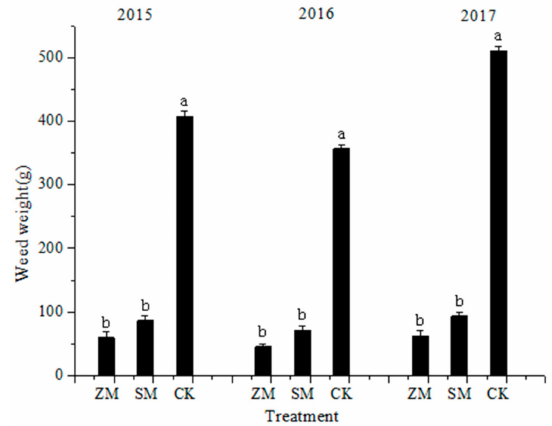
Figure 1. Comparison of weed for ZM and CK. Note: ZM: Plant fiber-based degradable film.